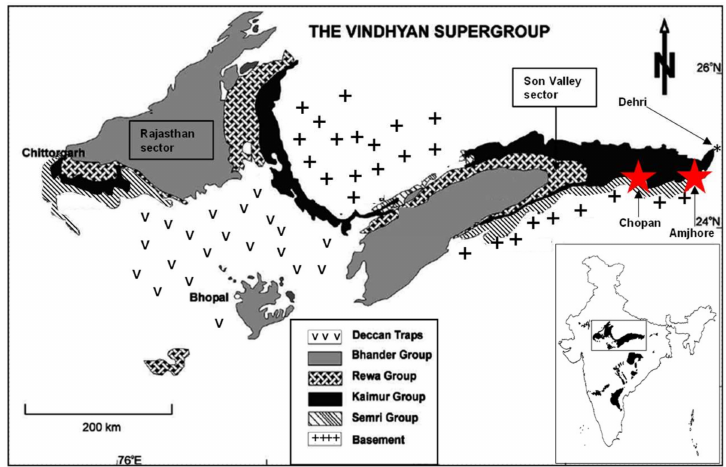
Figure 1. Geological sketch map of the Vindhyan Basin modified after [25] showing the two main sectors: Rajasthan in the west and Son valley in the east. The inset shows the di ff erent Proterozoic basins in India and the location of the Vindhyan basin in the northern cratonic